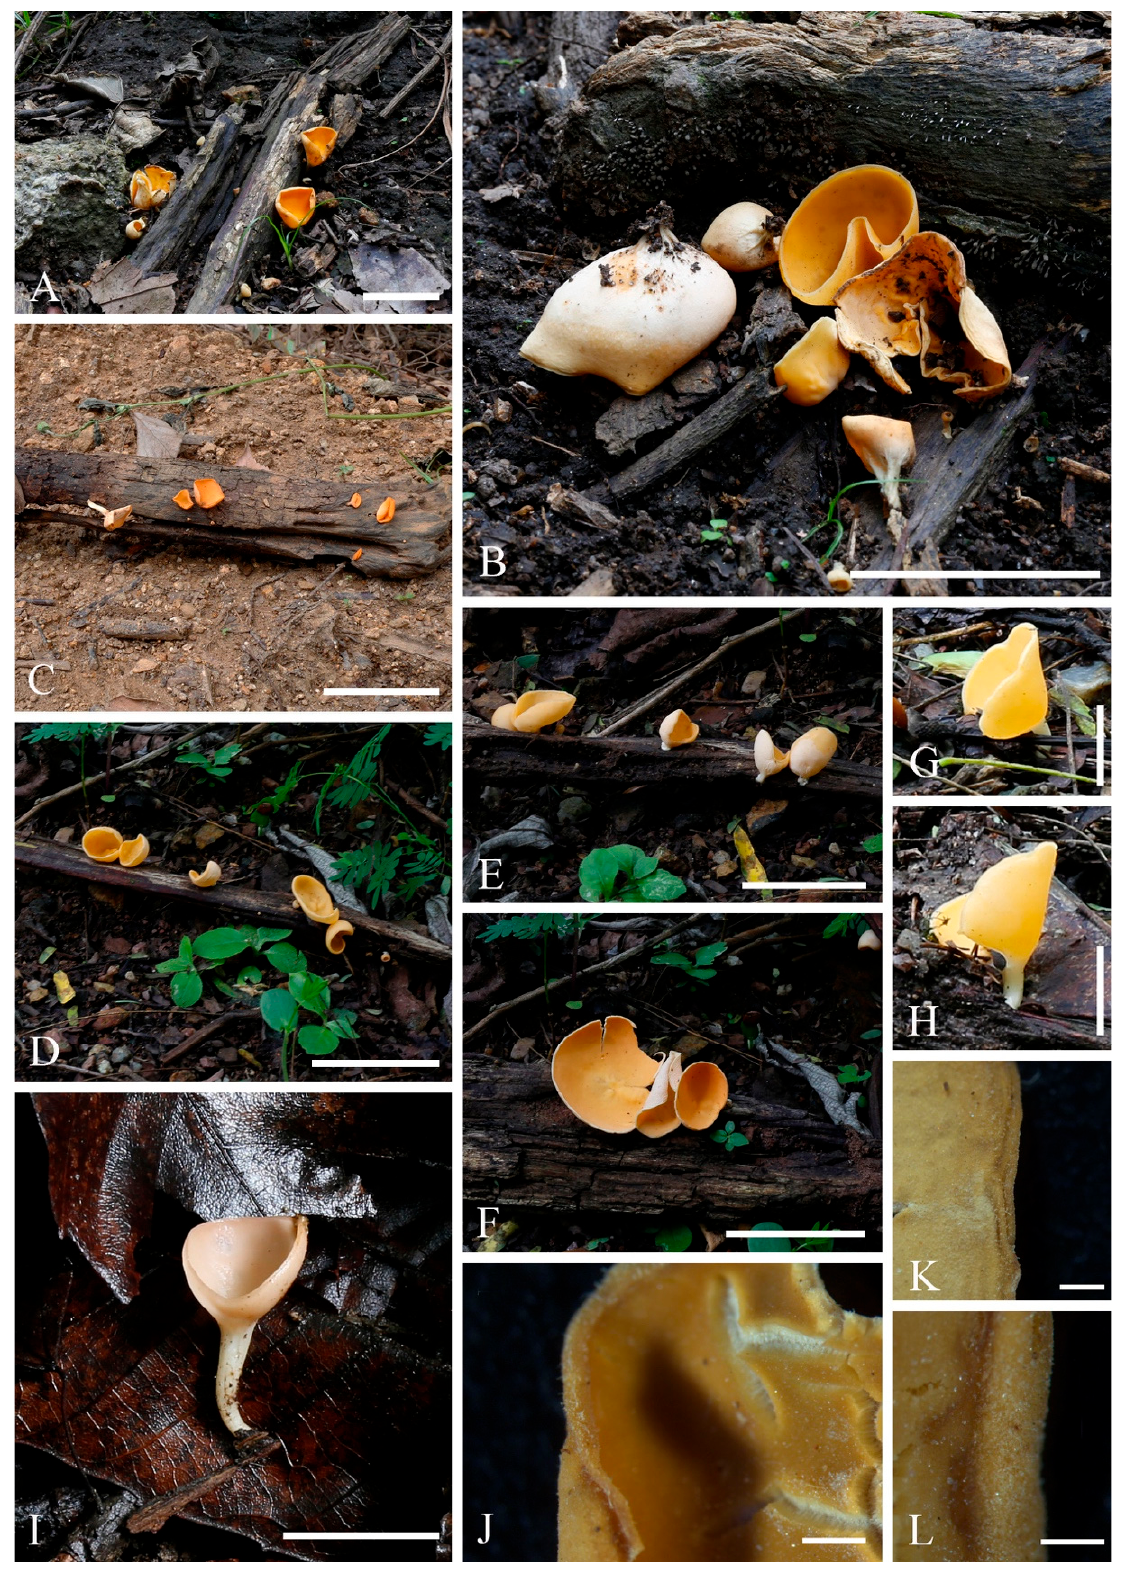
Figure 3. Cookeina indica . ( A – I ) Fresh apothecia [( A , B ) HKAS 121171. ( C ) HKAS 121172. ( D – H ) HKAS 121173. ( I ) HKAS 121174.] ( J ) Margin (HKAS 121173). ( K ) Receptacle surface of an apothecium (HKAS 121173). ( L ) A concentric sulcus (HKAS 121173). Scale bars ( A , B , F ) = 5 cm; ( C – E ) = 10 cm; ( G – I ) = 3 cm; ( J , K ) = 1000 μ m; ( L ) = 500 μ m.